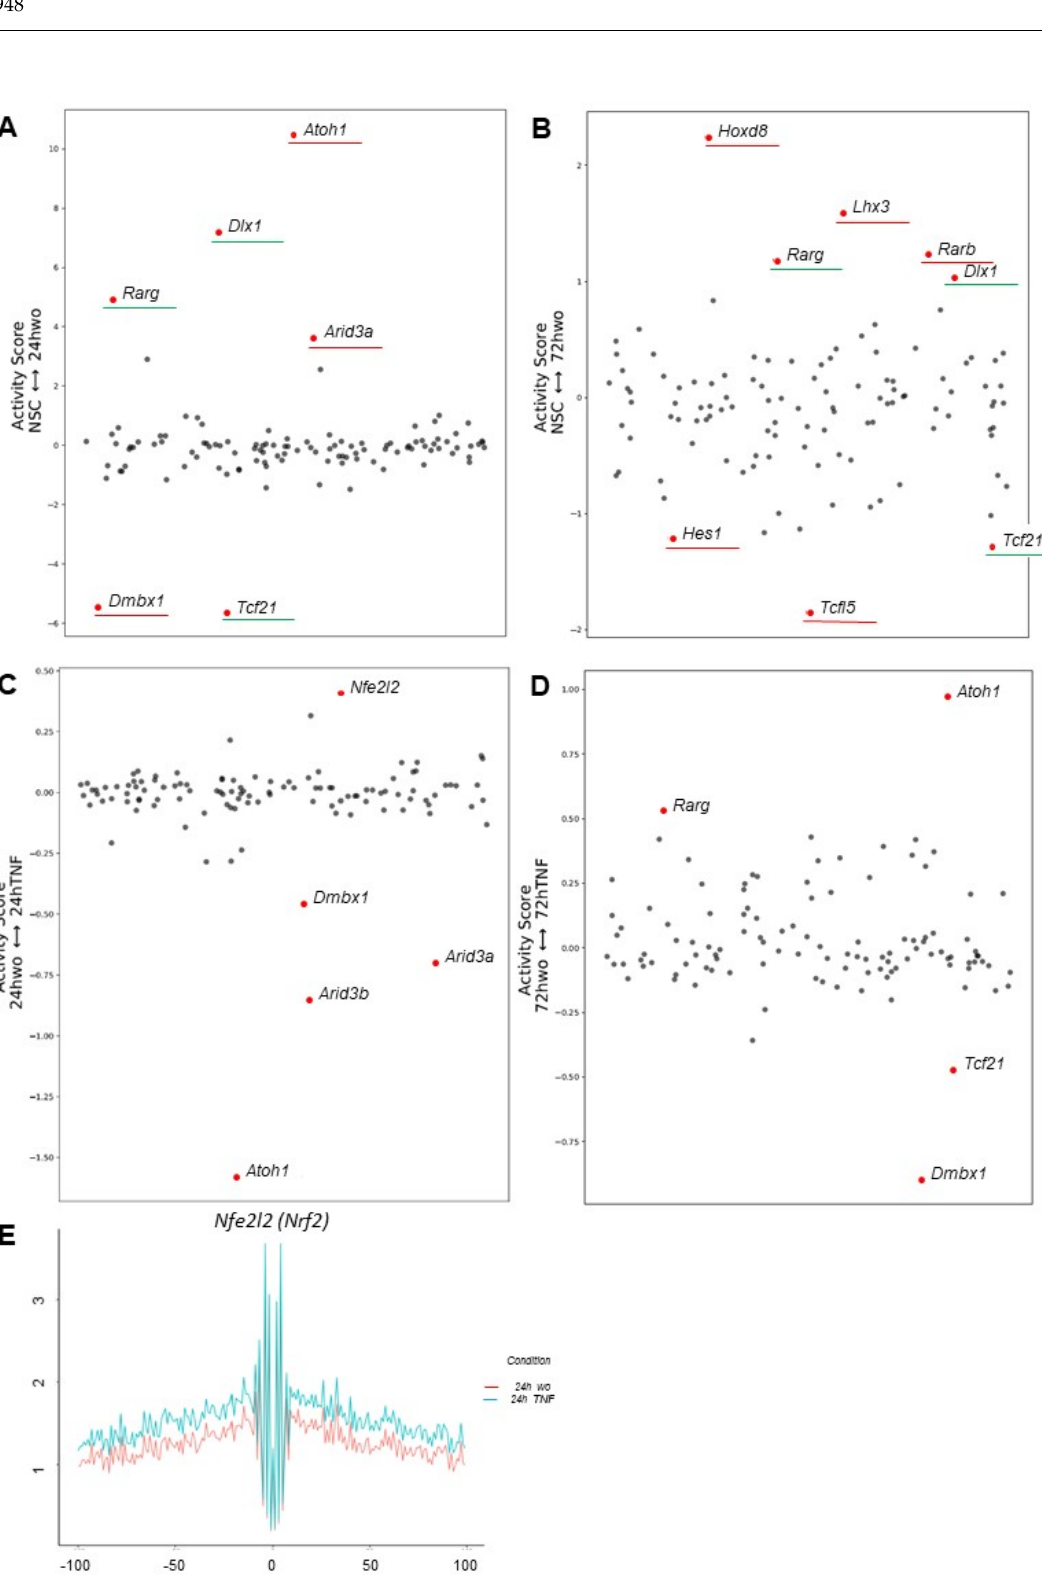
Figure 5. Chromatin footprinting activity under normal and inflammatory conditions. ( A – D ) Activity score plots at 24 and 72 h time points under ( A , B ) normal and ( C , D ) inflammatory conditions. In ( A , B ), shared TF binding motifs at 24 and 72 h are underlined in green, while unique TF binding motifs are in red. ( E ) Comparison of the activity of Nfe2l2 (Nrf2) gene based on motif enrichment analysis at 24 h between normal (red line) and inflammatory (blue line)